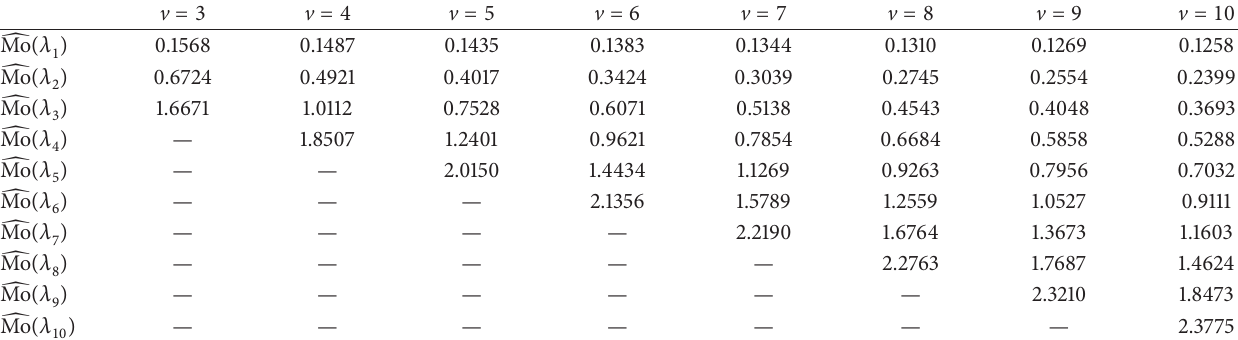
Table 1: Numerical estimates of the mode of the ordered eigenvalues {𝜆 1 ,...,𝜆 V } of Σ ∼ W V (2 V , (2 V ) −1 ⋅ I V ) with V = 3,...,10 . The estimates have been obtained from Grenander’s mode estimator